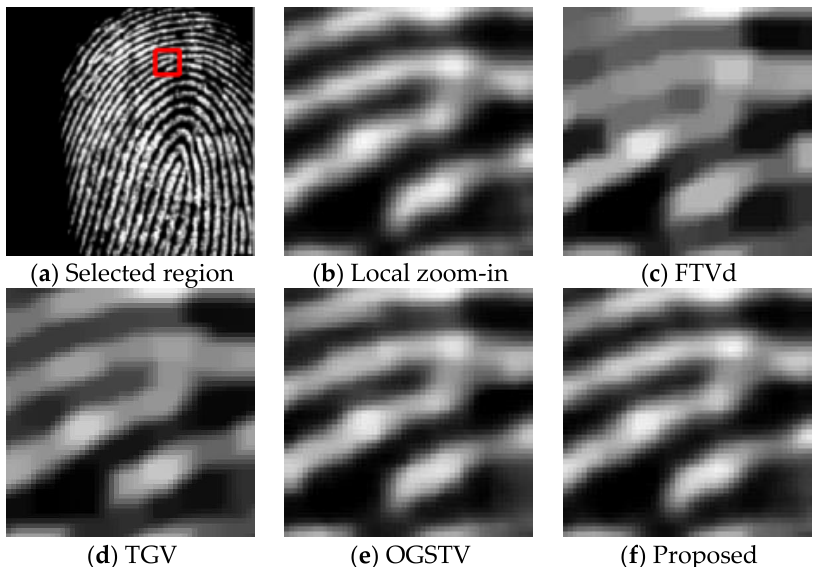
Figure 9. Local zoomed-in images from Figure 7 for better comparison: ( a ) selected region of the original image; ( b ) local zoomed-in image of the selected region; ( c ) FTVd-restored image; ( d ) TGV-restored image; ( e ) OGSTV-restored image; ( f ) proposed algorithm-restored image.